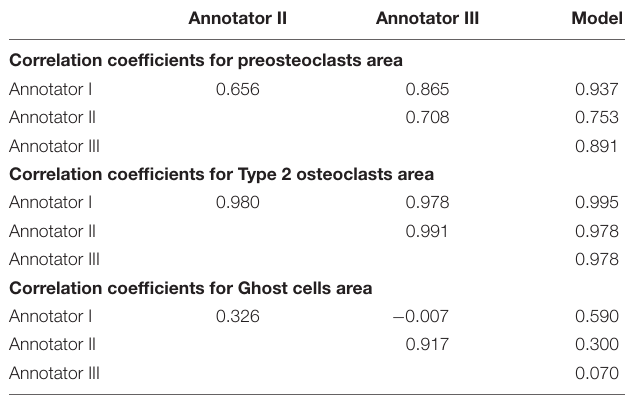
TABLE 1 | Correlation coefficients between human annotators and the model for cell counting.